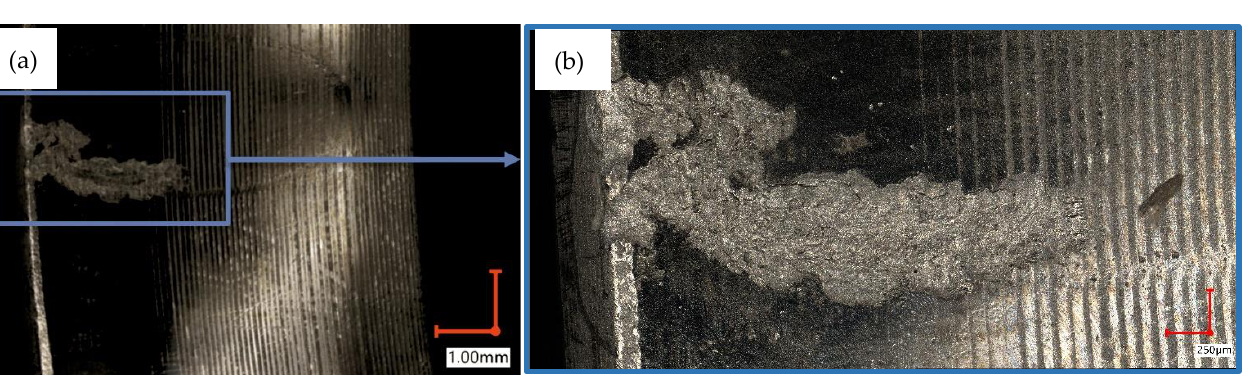
Figure 9. The hollow defect appeared after the last test stage ( a ) — ×100 magnification; ( b ) — ×300 magnification).